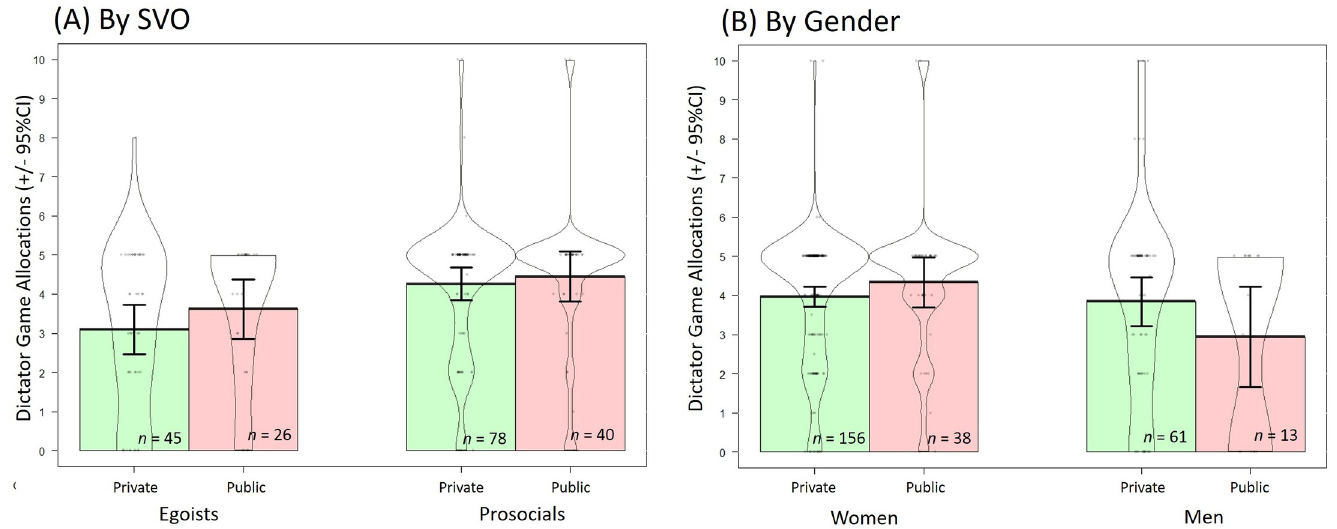
Fig 5. Dictator game allocations by public and private (combined eyes and control) conditions. Plot (A) is separated by SVO, where colored areas represent traditional bar graphs, where egoists are in blue, and prosocials in green. Plot (B) is separated by gender, with women in red and men and blue. Contours are violin plots which demonstrate the distribution of responses for that condition (+/- 95% confidence intervals). Dots are individual responses, with jitter so they don’t all overlap.